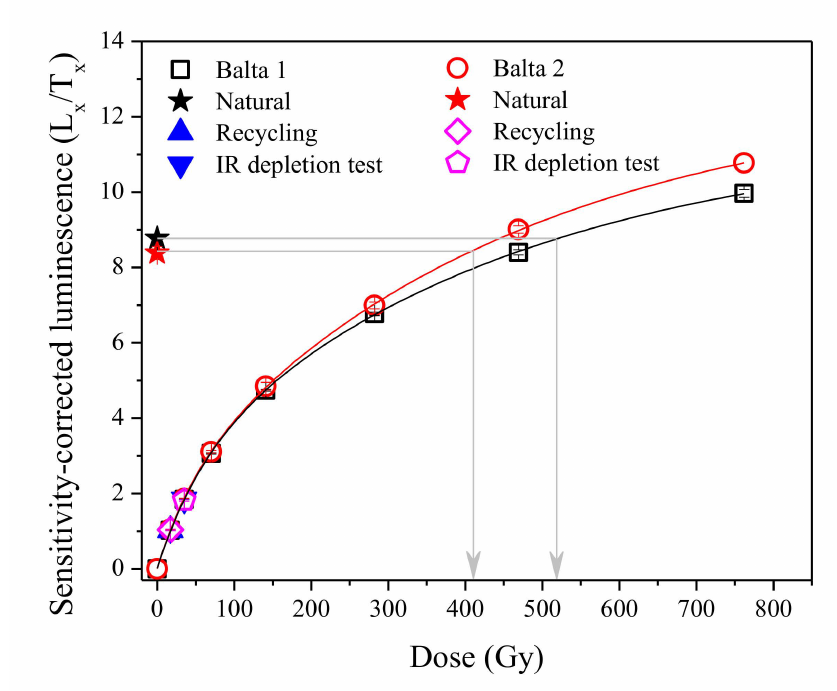
Figure A2. Average growth curves for accepted aliquots of samples Balta 1 and Balta